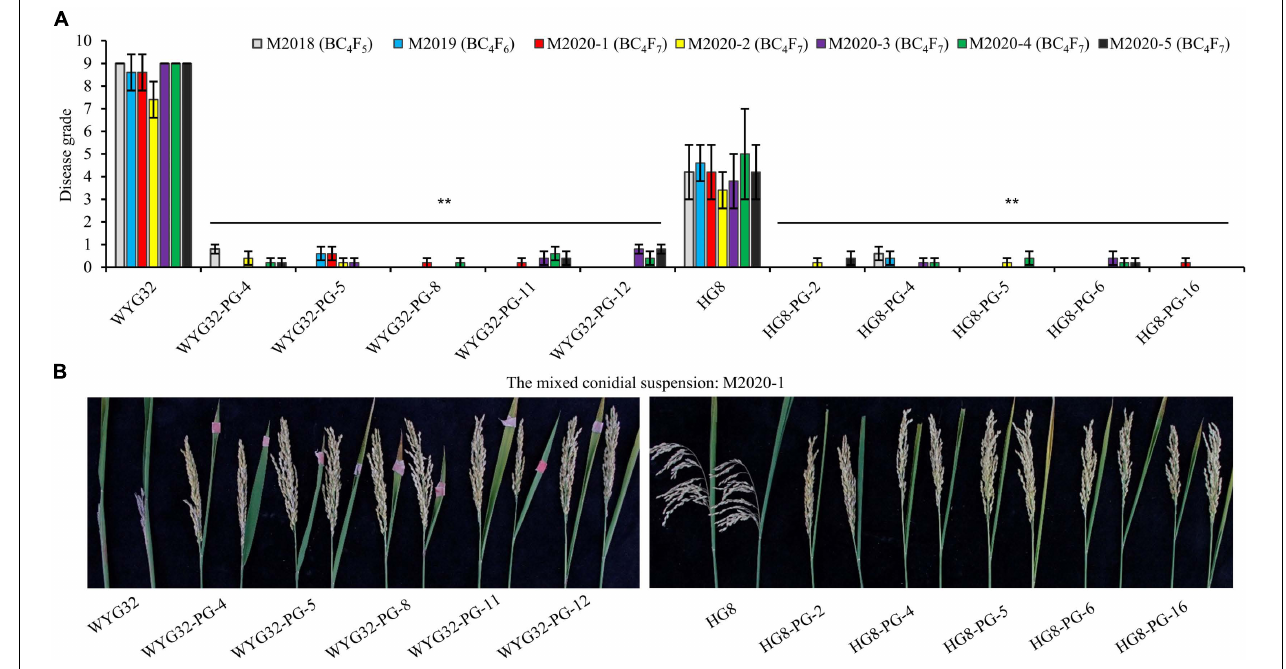
FIGURE 3 | Panicle blast resistance scores of ABLs and the recurrent parents at the ripening stage. (A) Comparison of disease grades among ABLs and the recurrent parents (WYG32 and HG8) against the mixed conidial suspensions of M. oryzae isolates. (B) Panicle blast disease reactions of ABLs against the mixed conidial suspension M2020-1. ** P < 0.01 compared with the recurrent parent by Student’s t -test.